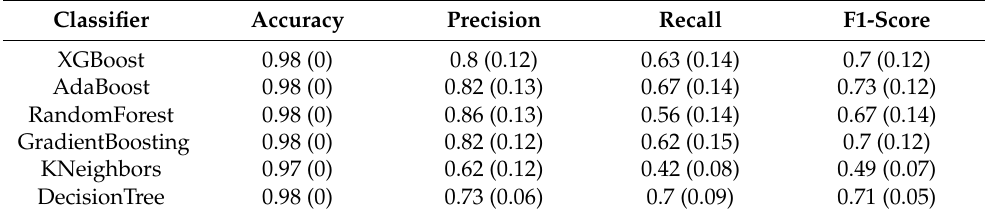
Table 3. Models’ performance for Linear Interpolation (standard deviation in brackets).